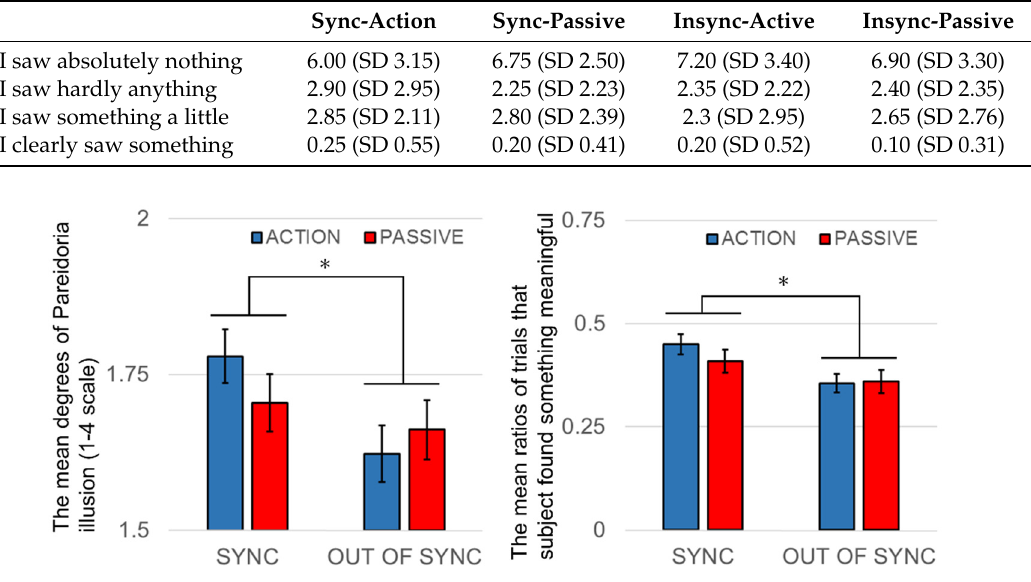
Figure 2. The mean of the degrees of pareidolia rated by the participants for each condition ( left ) and the mean of the ratios of the trials in which the participants saw something meaningful ( right ). (* p < Table 1. The mean number of times each option was selected for each condition.